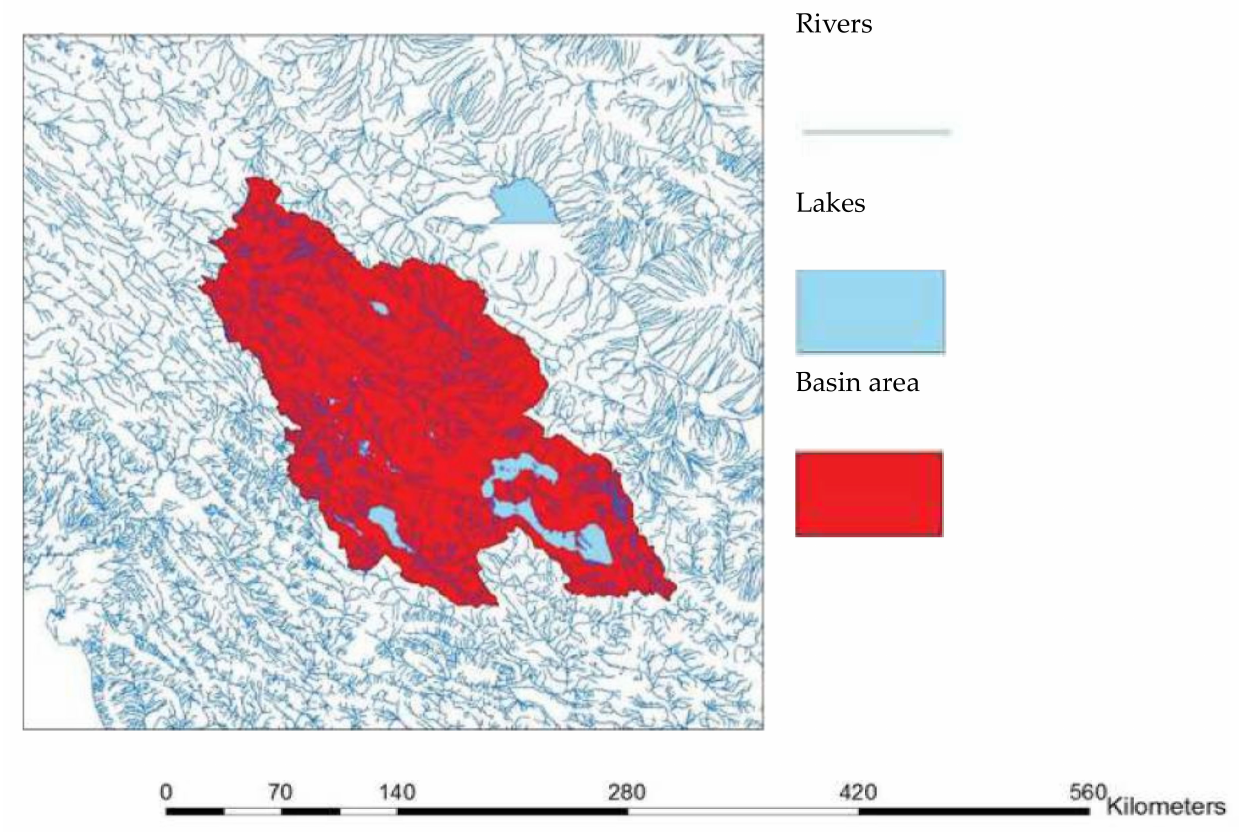
Figure 6. Bakhtegan Tashk Maharlou Basin